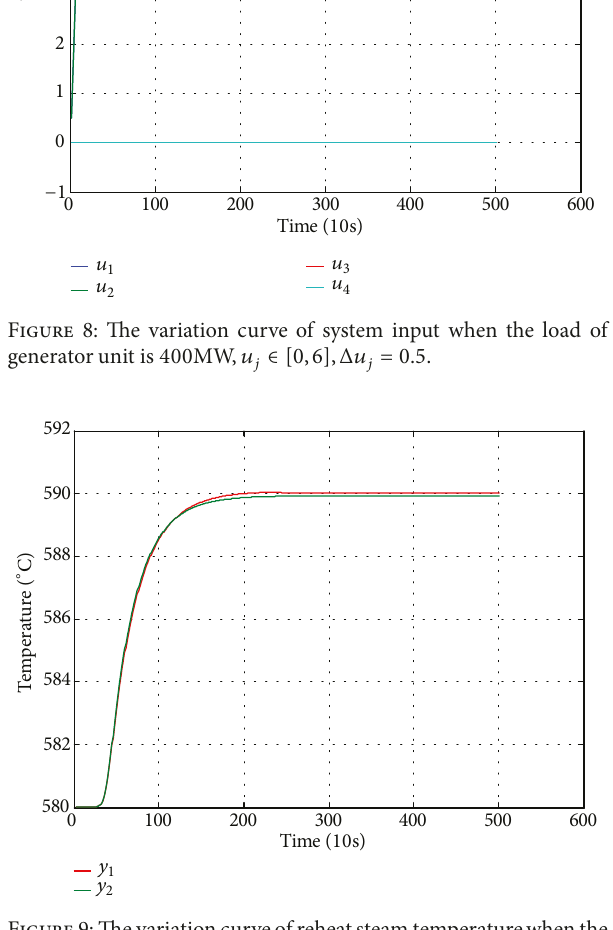
Figure 9: The variation curveof reheatsteam temperaturewhen the load of generator unit is 400MW and 𝑢 𝑗 ∈ [0,7.5] .